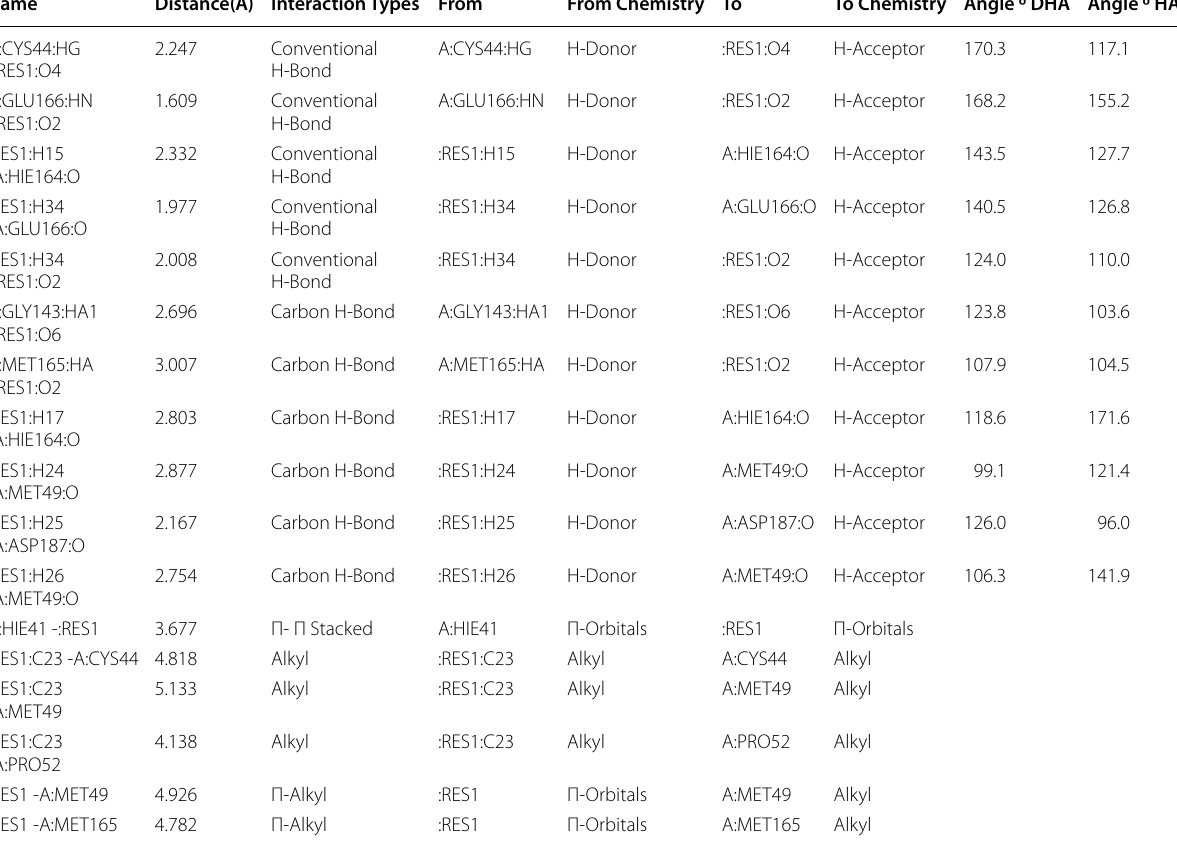
Table 6 Interaction types with surrounding amino acids of SARS CoV 2 Main Protease (PDB ID: 6xbh) with inhibitor Index number 819